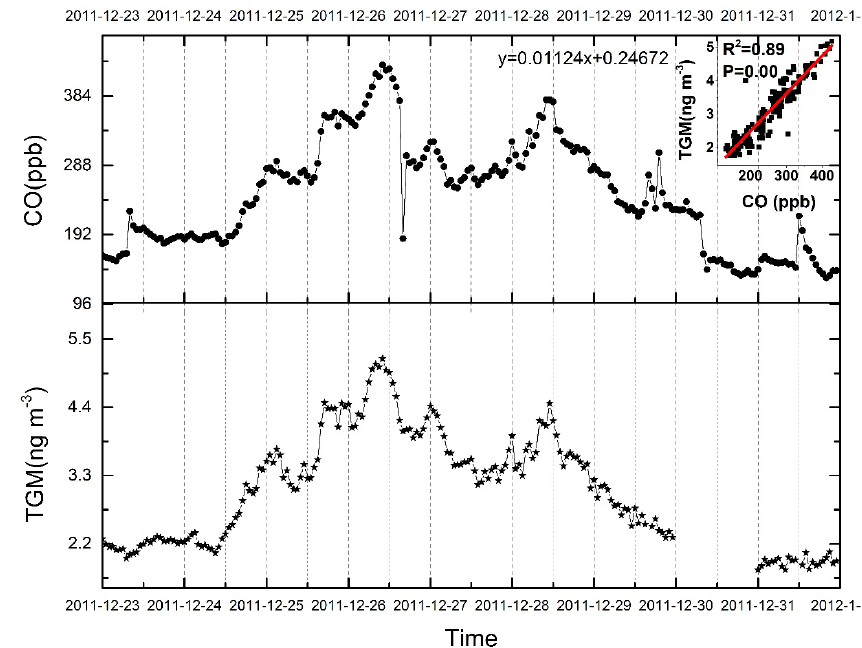
Figure 12. Correlation of TGM and CO in 23–31 December 2011 during the non-ISM period.